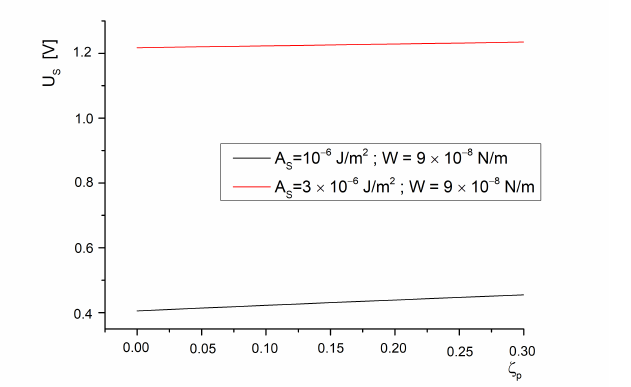
Figure 5. Saturation voltage versus anchoring anisotropy parameter for two different anchoring energies on the support